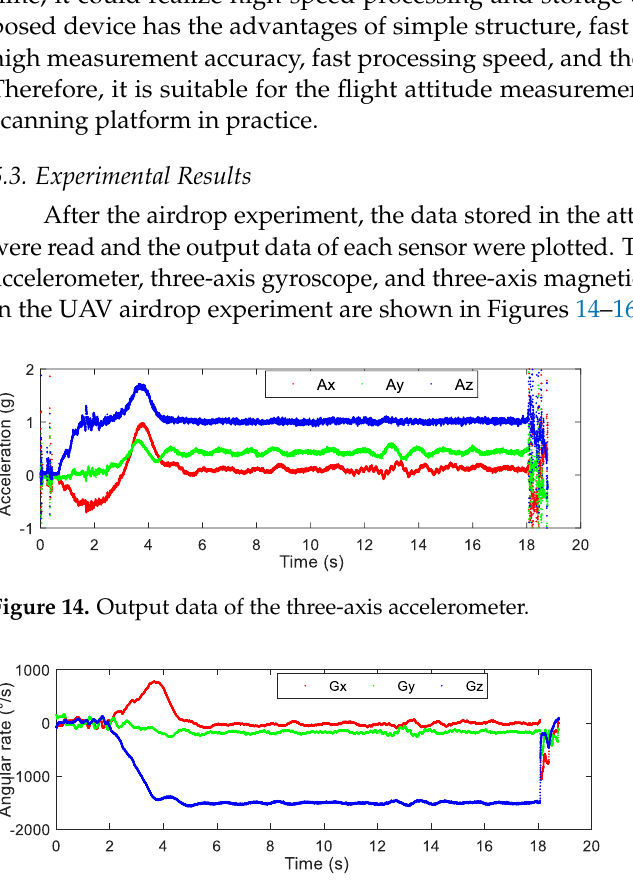
Figure 15. Output data of the three-axis gyroscope.